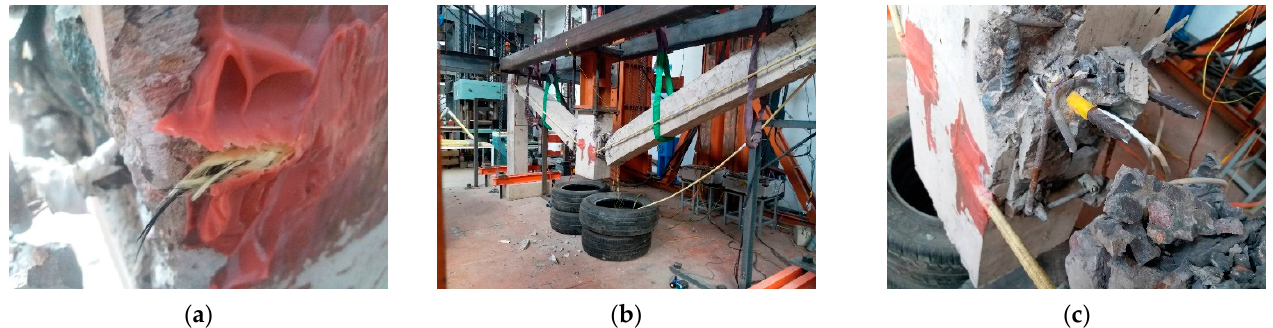
Figure 11. CFR fracture and collapse failure of the strengthened specimen: ( a ) CFR fracture; ( b ) Global perspective of collapse failure; ( c ) Collapse failure details at the right side of the middle column.